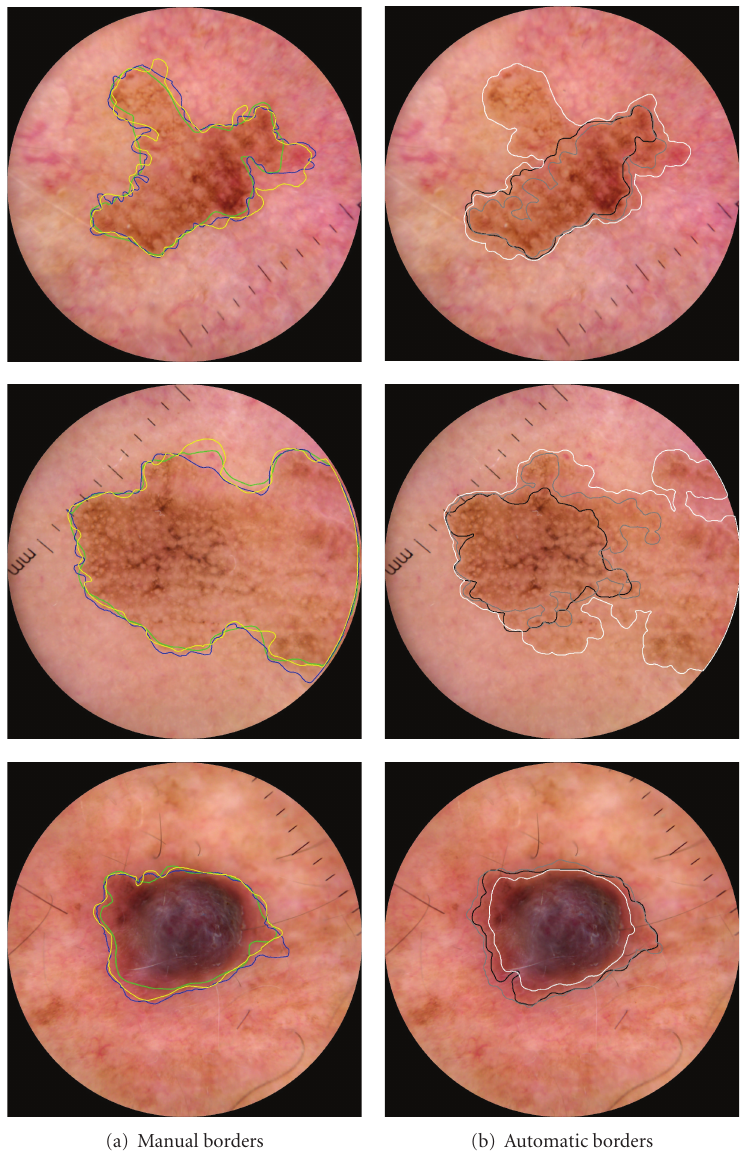
Figure 9: Example of lesions in the test set and the border provided by (a) the three dermatologists and (b) the automatic borders by AT (black border), SRM (gray border), and the proposed ICS algorithm (white border). None of the methods performed better in all